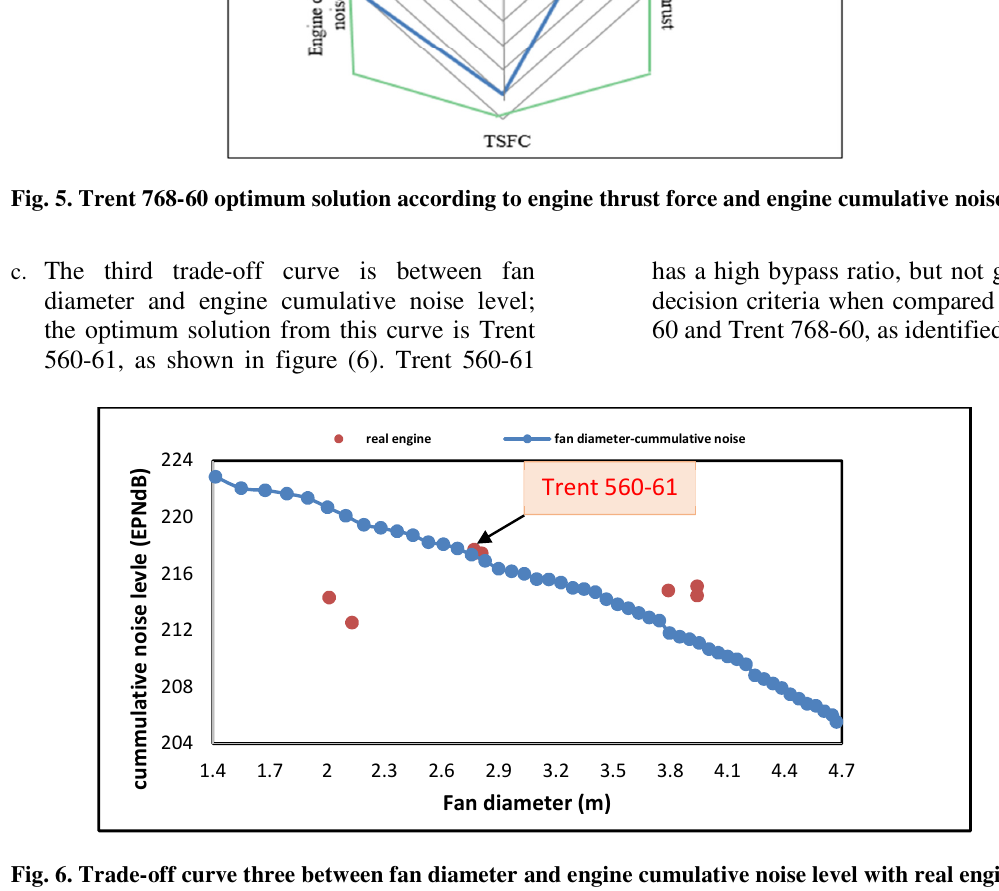
Fig. 6. Trade-off curve three between fan diameter and engine cumulative noise level with real engines.